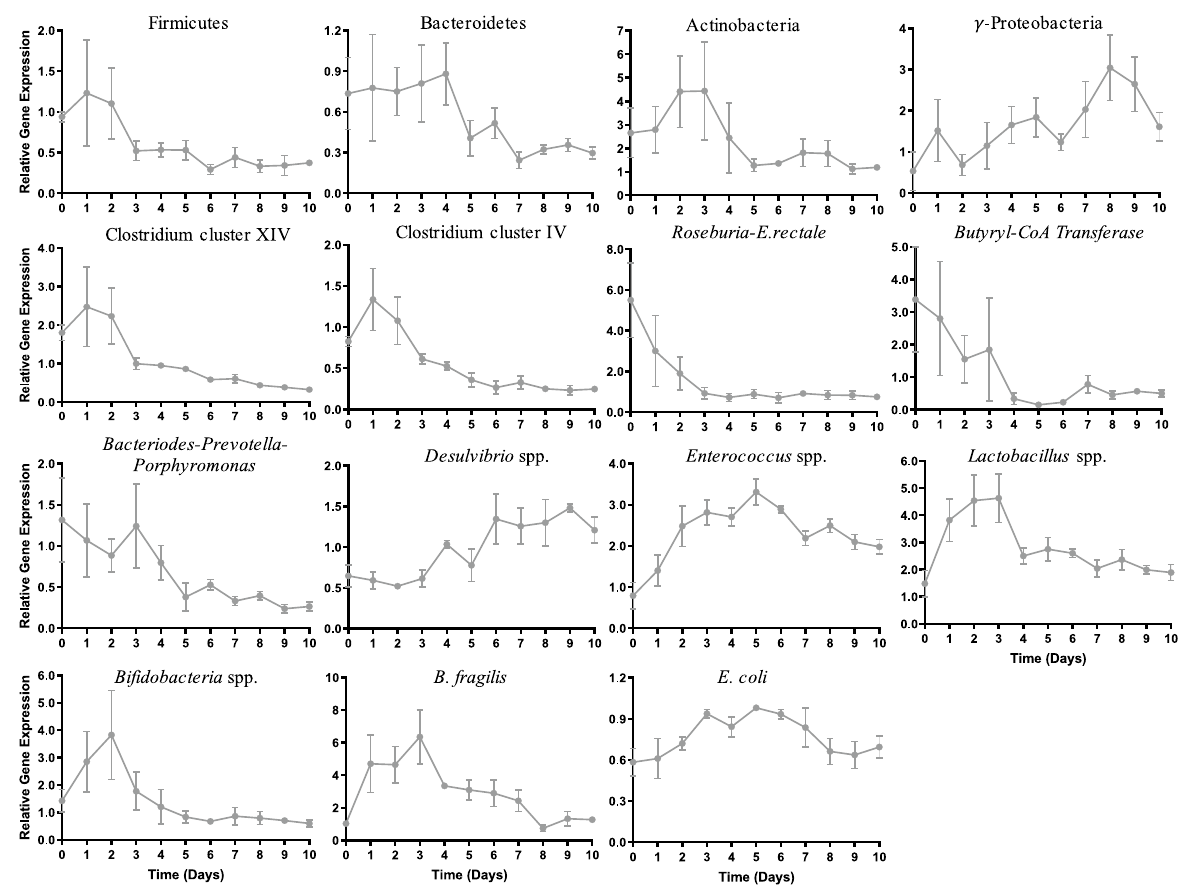
Figure 3. Real-time PCR quantification of 16 S V1–V3 region of gut microbiota in the ABIOME. Quantification of 16S rRNA V1–V3 regions of the gut microbiome was conducted using qPCR and gene expression relative to a reference sample and the total amount of bacteria as indicated by the 27F/519R primer set. Relative gene expression was calculated using the 2 −ΔΔCT method. Each time-point represents n = 3 independent trials +/− SEM. Variability over time was conducted with a one-way ANOVA using Kruskal Wallis analysis where *p < 0.05.